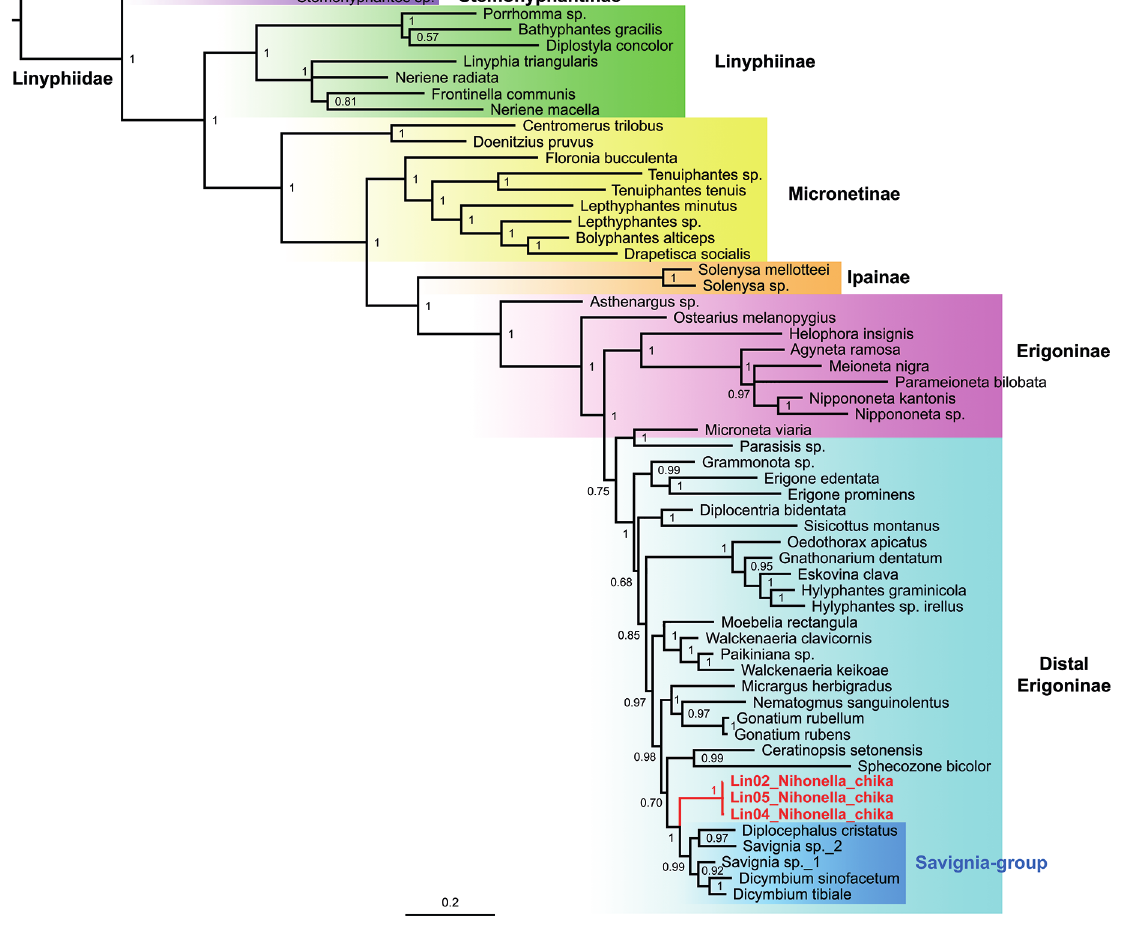
Fig. 5. Bayesian inference phylogenetic tree of Erigoninae and other subfamilies of Linyphiidae based on the five concatenated genes discussed in the text. Each color denotes a different subfamily while the Savignia group is indicated in blue. The phylogenetic position of the genus Nihonella gen. nov. is highlighted in red. Numbers at each node denote posterior probability support. Branch lengths are scaled in relation to the number of substitutions per